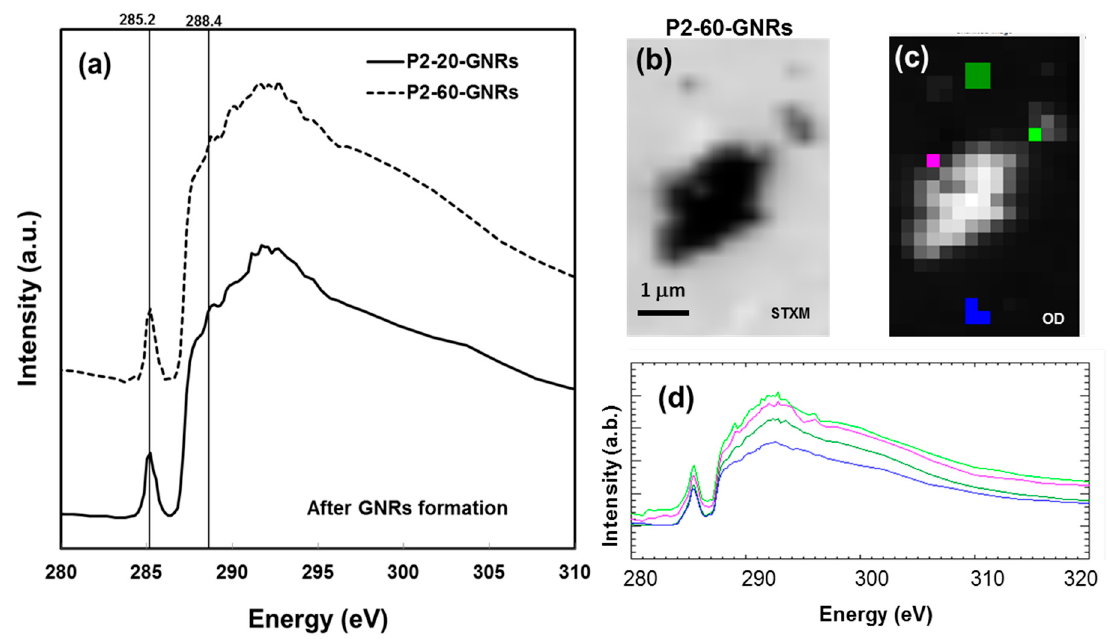
Figure 6. ( a ) NEXAFS C1s K-edge for P1-10-GNRs and P2-60-GNRs (after GNRs formation); ( b ) SXM image of a region of interest (ROI) in P2-60-GNRs sample chosen for detailed carbon spectroscopy; ( c ) Optical Density (OD) image of the chosen ROI with colour coded areas in which NEXAFS spectra have been extracted; ( d ) NEXAFS spectra corresponding to the coloured area shown in ( c ).